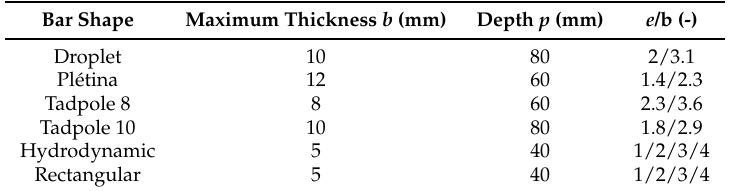
Figure 4. Transversal support dimensions: U-shaped on the left and profiled shapes on the right, placed in front of the spacers. Table 2. Bar parameters (b,p) for the different bar shapes (Droplet, Plétina, Tadpole 8, Tadpole 10, hydrodynamic,